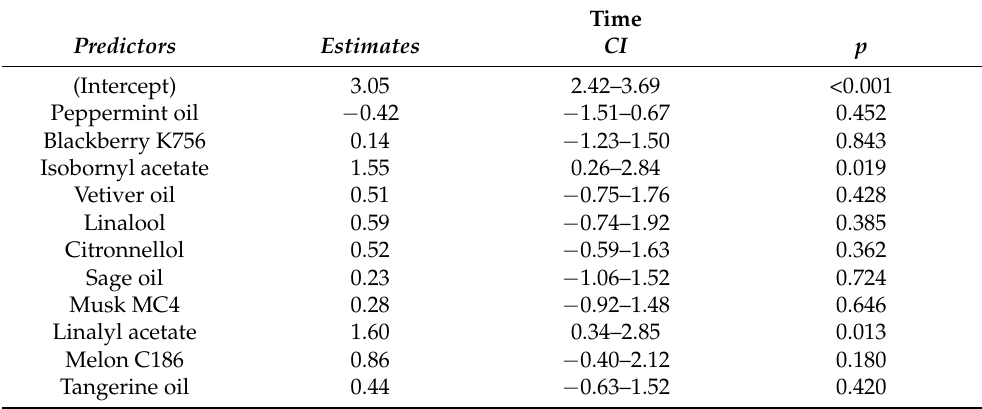
Table 4. Sniffing activity (duration): linear mixed model displaying associations between duration of sniffing activity (outcome) and administered odors (covariates), with dogs’ IDs as a random factor and glycol as the reference